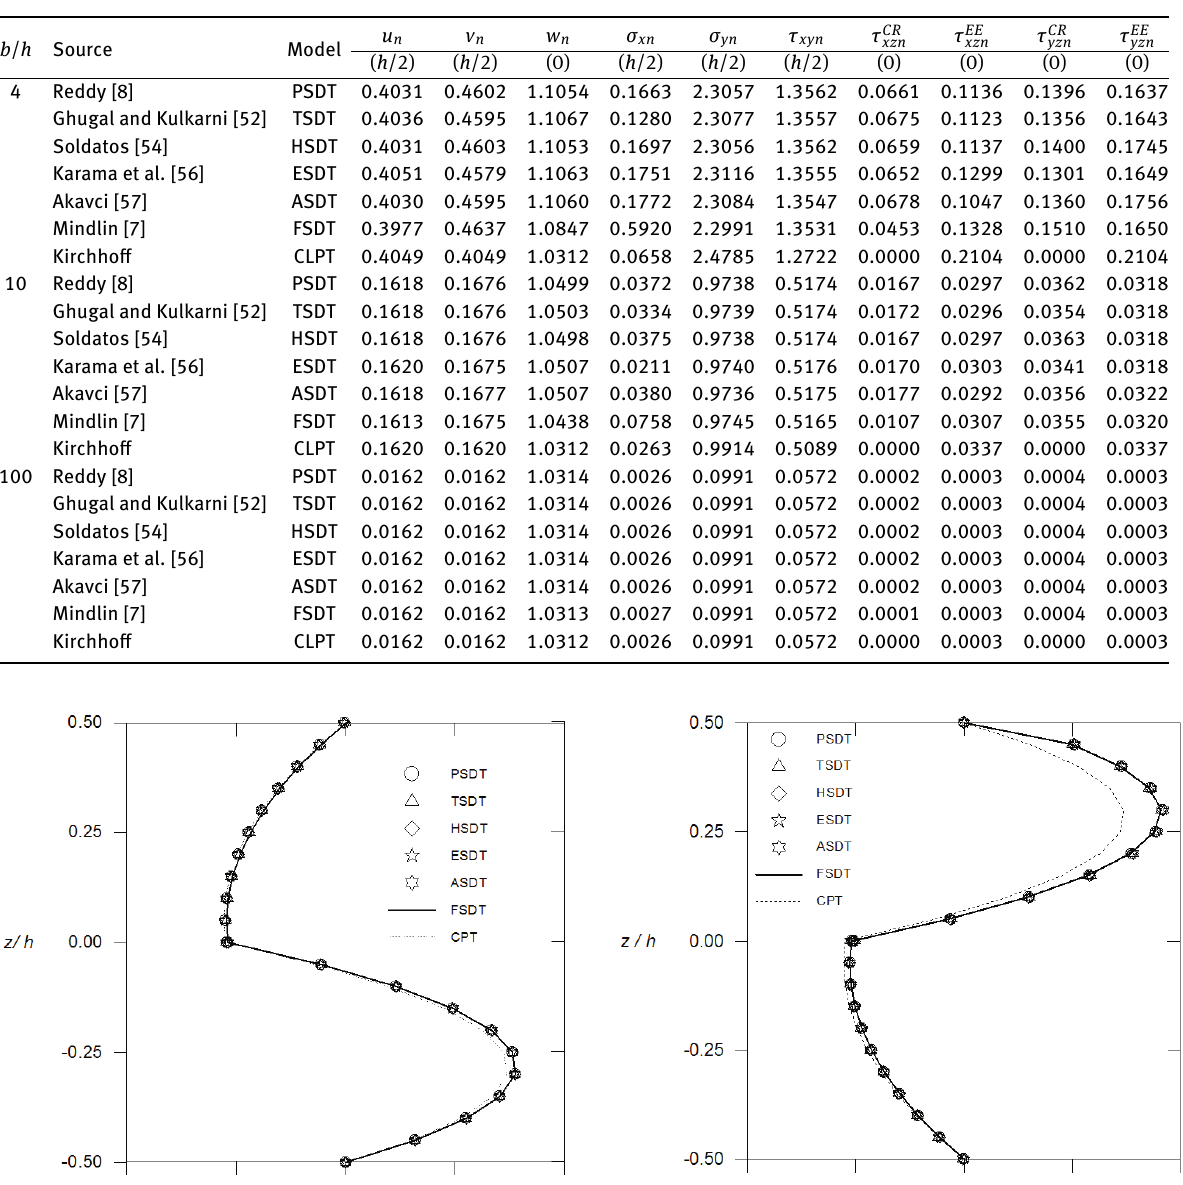
Table 3: Comparison of thermal displacement and stresses of simply supported square ( b = a ) three layered (0 ∘ /90 ∘ /0 ∘ ) symmetric lami- nated composite plate subjected to sinusoidally distributed linear thermal loading.